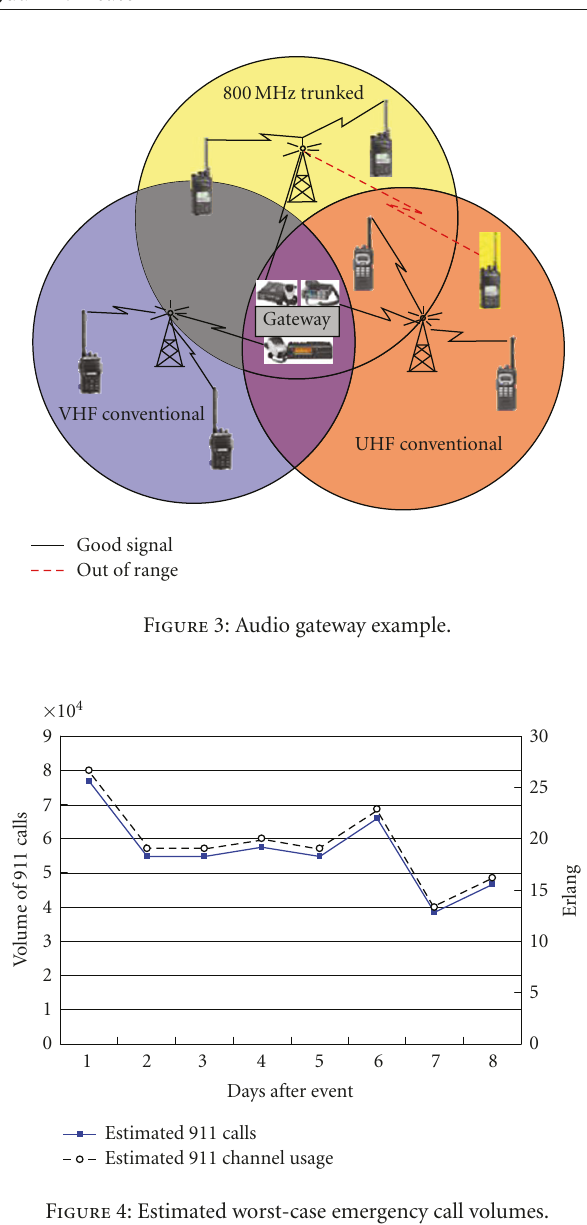
Figure 4: Estimated worst-case emergency call